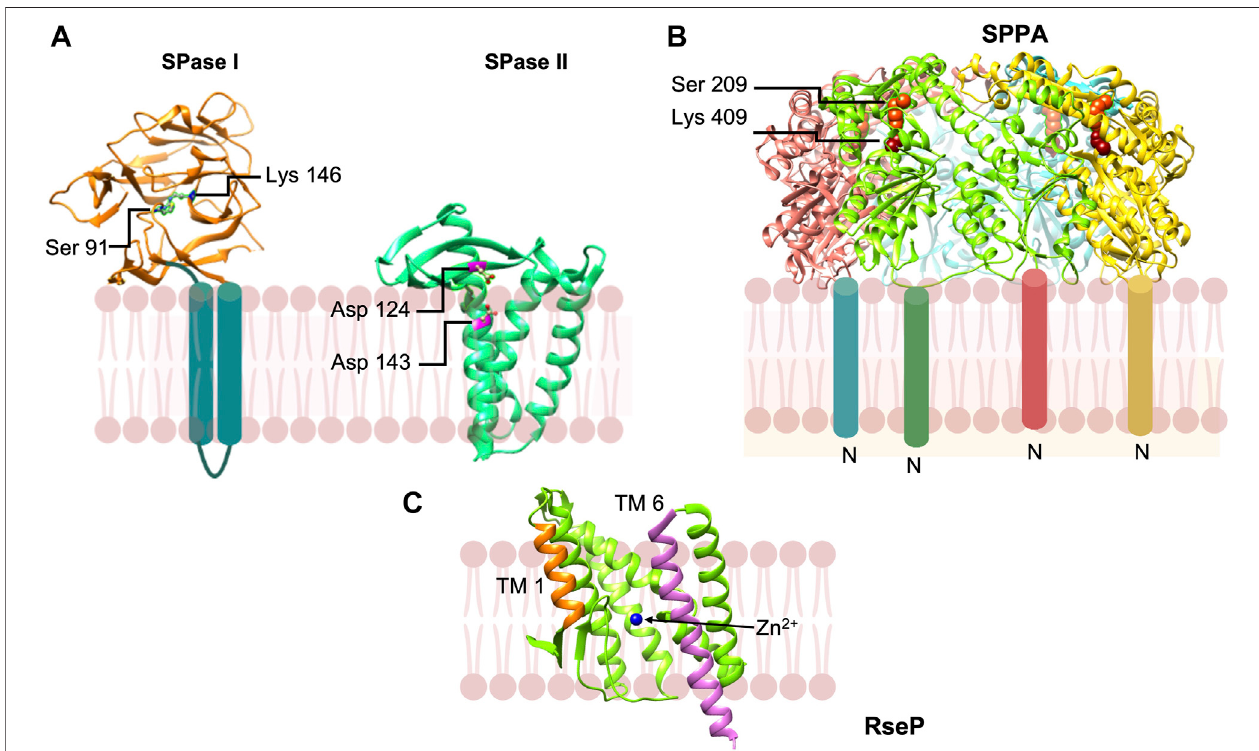
FIGURE9 | Peptidasesinvolvedin the removal of signal peptidesand their degradation. (A) Signal peptidase 1 [adapted from Paetzel et al.(2004) PDB: 1T7D] isa novelSer-Lysproteasethatcleavesthepreproteinatthemembranesurfaceontheperiplasmicside.Signalpeptidase2[adaptedfromVogeleyetal.(2016)PDB:5DIR]is anasparticacidproteasethatcleavesadiacylglyceridemodi fi edpreproteinswithintheplaneofthemembrane. (B) SppA[adaptedfromKimetal.(2008)PDB:3BF0]isa tetramericproteinthatdegradessignalpeptideswhicharereleasedfromthemembraneintotheperiplasmicspace.SppAemploysaSer-Lysdyadandisanchored to the membrane by an amino terminal TM segment. (C) RseP signal peptide peptidase [from Methanocaldococcus jannaschii adapted from Feng et al. (2007) PDB: 3B4R] in open state. Both water molecules and peptide substrates reach the active site containing Zn 2+ ion (blue) during its open state.